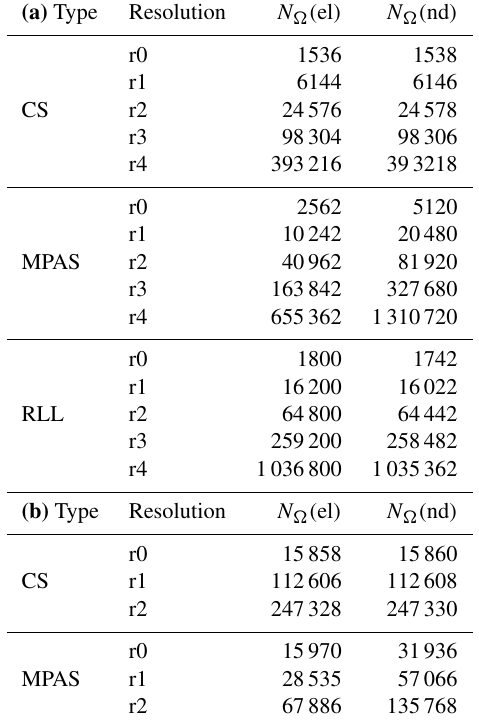
Table 1. Details on the number of elements ( N (cid:127) ( el ) ) and nodes ( N (cid:127) ( nd ) ) for different mesh types and resolutions used in the